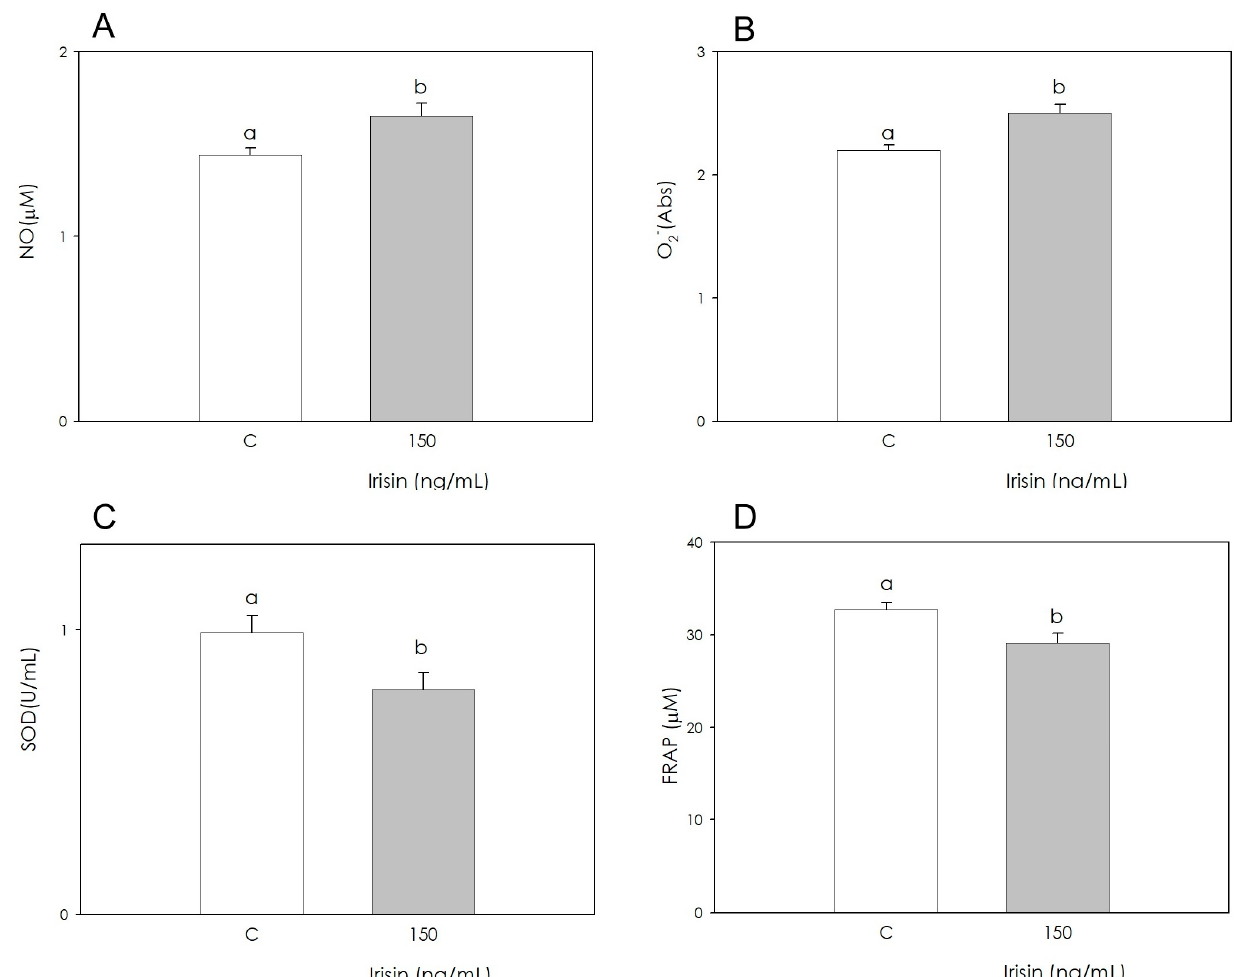
Figure 3. Effect of the treatment with Irisin (150 ng/mL) for 48 h on swine adipose stromal cell nitric oxide (NO; A ), and superoxide anion (O 2 − ; B ) generation, superoxide dismutase activity (SOD; C ) and non-enzymatic scavenging activity (FRAP; D ). Data, expressed as µM ( A , D ), absorbance (Abs; B ) or U/mL ( C ), represent the mean ± SEM of six replicates/treatment repeated in five different experiments. Different letters on the bars indicate a significant difference ( p < 0.05) among treatments as calculated by ANOVA and the Scheffè’ F test.